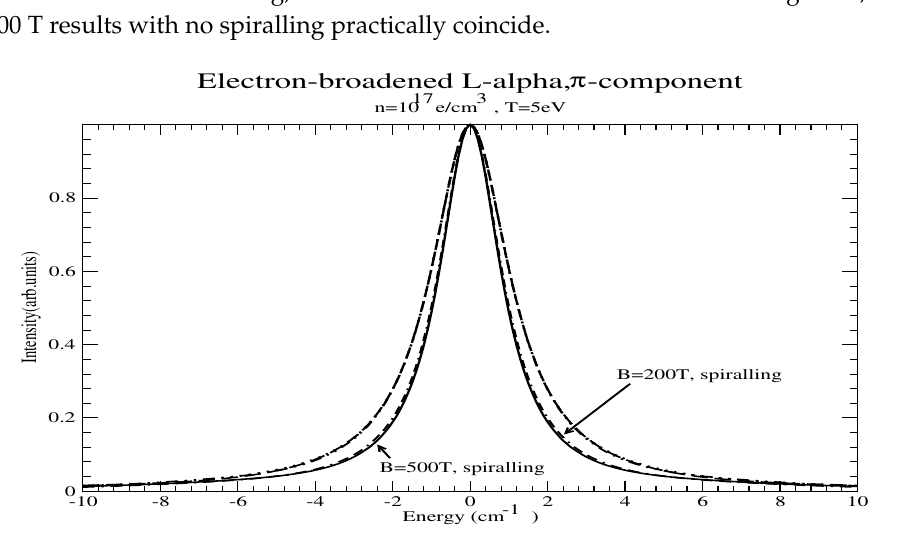
Figure 5. Line profile of the Ly − α π - compoment with and without account of spiralling for n = 10 17 e/cm 3 , T = 5 eV and B = 0, 200 and 500 T. The horizontal scale represents energy difference from the unperturbed line